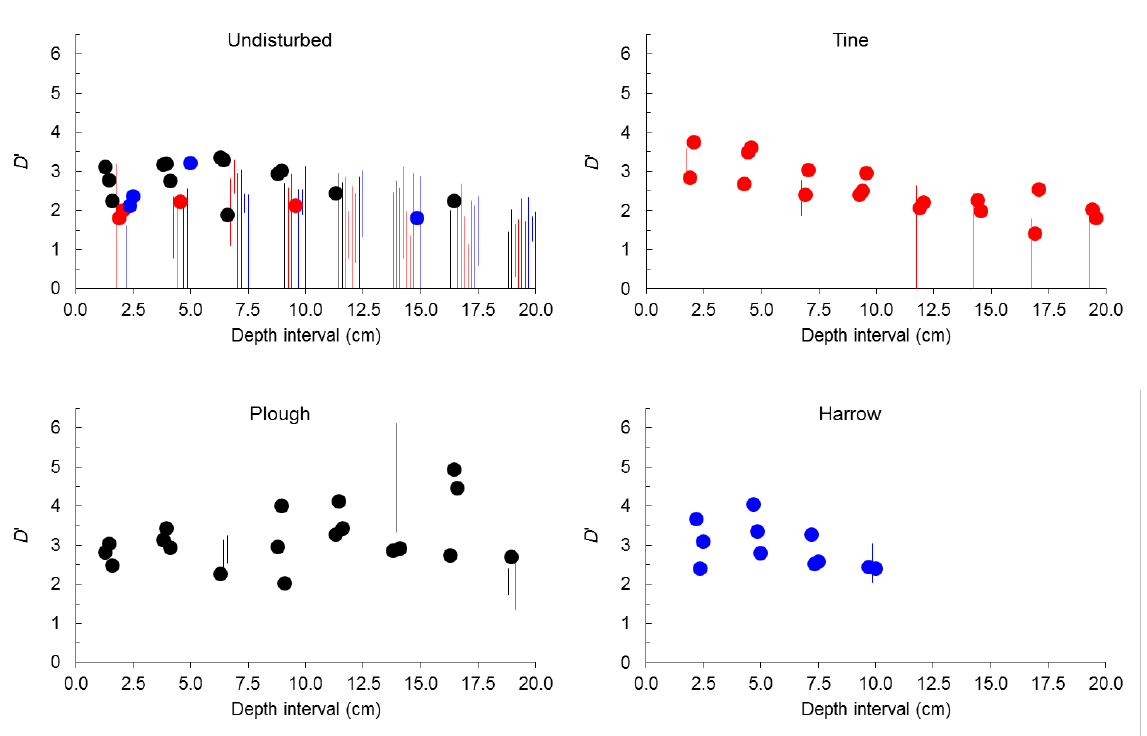
Figure 3. Value (points) or range (bars) of size-number distributions of seeds expressed by D ’ for spherical seeds before tillage (undisturbed) and after tine, harrow or plough at 2.5 cm depth